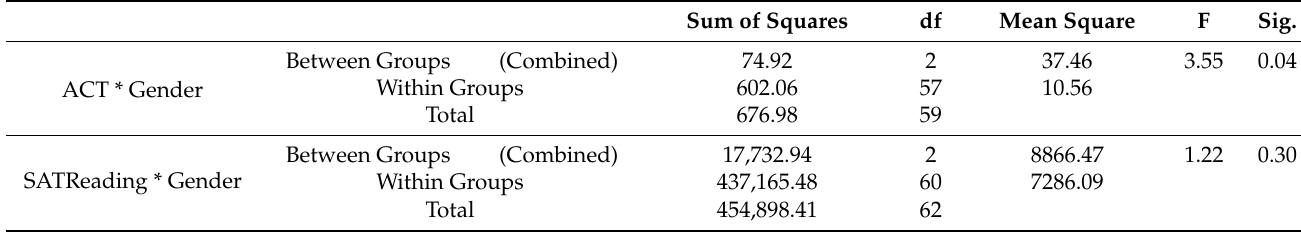
Table 2. Gender-based Analysis of